Question: Which visualization type does this figure use?
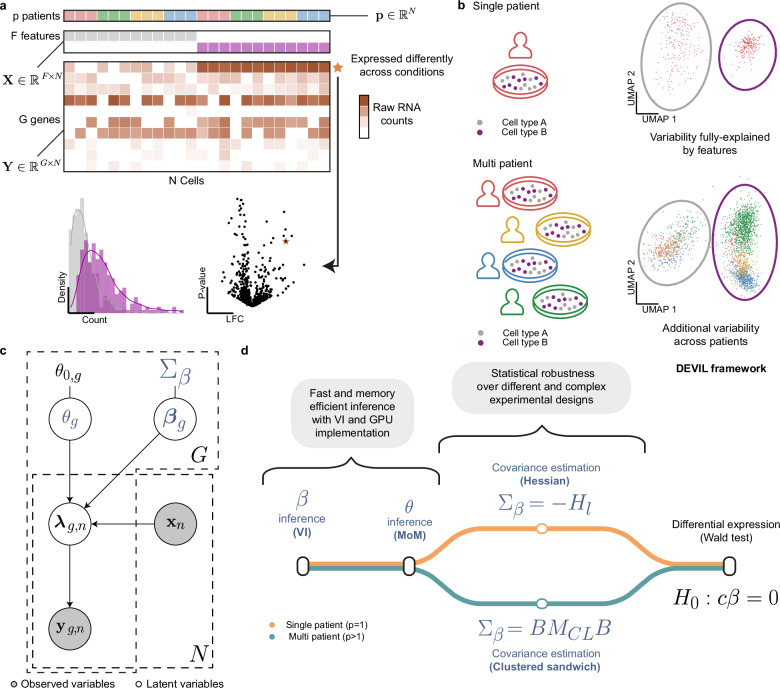
Answer: scatter